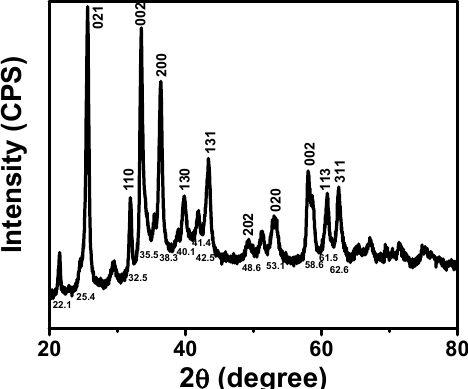
Figure 4. XRD patterns of bio-reduced CuO NPs.